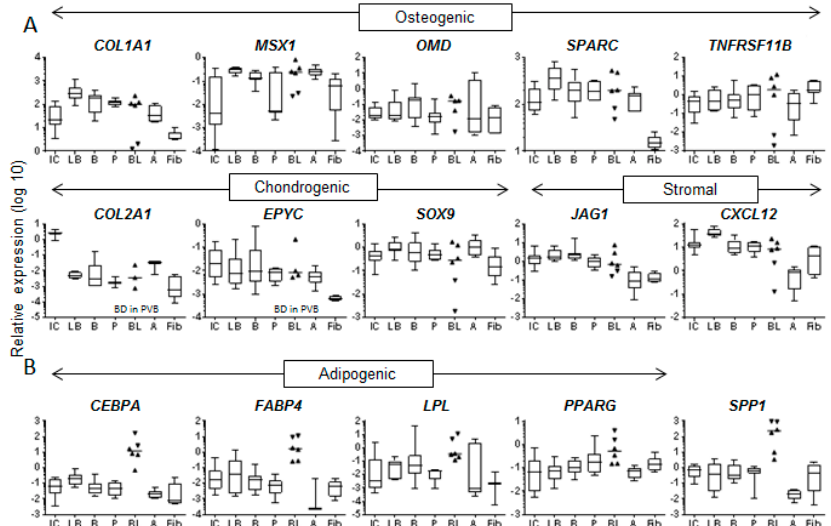
Figure 5. Differential expression of FV- and PV- blood-MSCs compared to other MSC types. A – Osteogenic, chondrogenic and stromal-support genes, B – adipogenic genes. FVB- and PVB-MSCs represented by standard and inverted triangles, respectively. Horizontal line = median (scatter and box / whisker), box/whisker = interquartile range/range, BD = below detection. IC = iliac crest marrow, LB = long bone marrow, B = control bone, P = periosteum, B = blood, A = adipose, Fib = fibroblast.